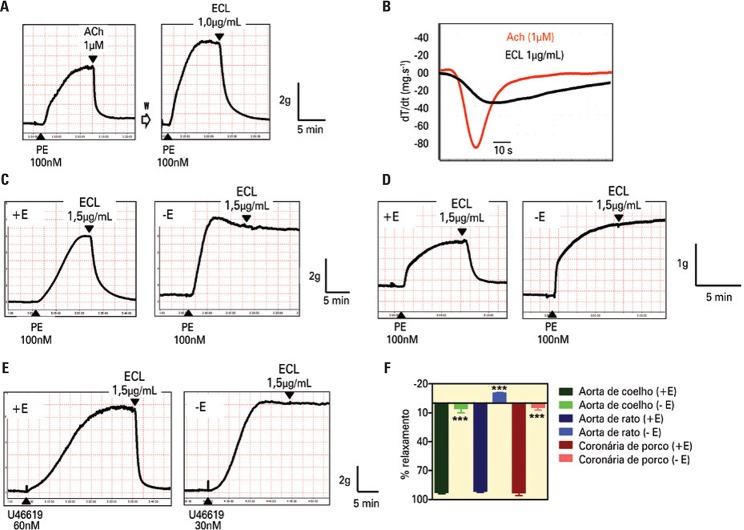
Traçados representativos mostrando o efeito da acetilcolina (ACh; 1µM) e do extrato de Combretum leprosum (ECL; 1,0µg/mL) sobre a tensão isométrica desenvolvida pelos anéis da aorta torácica de coelho pré-contraídos com fenilefrina (PE; 100nM) (A). Primeira derivada (dT/ dt, mg/s) dos relaxamentos induzidos por ECL (1,0µg/mL) e ACh (1µM) (B). Efeito do ECL (1,5µg/mL) sobre a tensão isométrica desenvolvida pelos anéis, com (+E) ou sem (-E) o endotélio, da aorta torácica de coelho (C), da aorta torácica de rato (D) pré-contraída com PE, e da artéria coronária direita de suínos pré-contraída com U46619 (E). Em (F), valores médios ± erro padrão da média (EPM) da magnitude do relaxamento observado em 4-20 experimentos semelhantes (a magnitude de relaxamento é expressa como porcentagem da magnitude das contrações induzidas por PE ou U46619). ***Teste bicaudal p<0,0001 (teste t não pareado). L: lavagem da preparação por 60 a 45 minutos